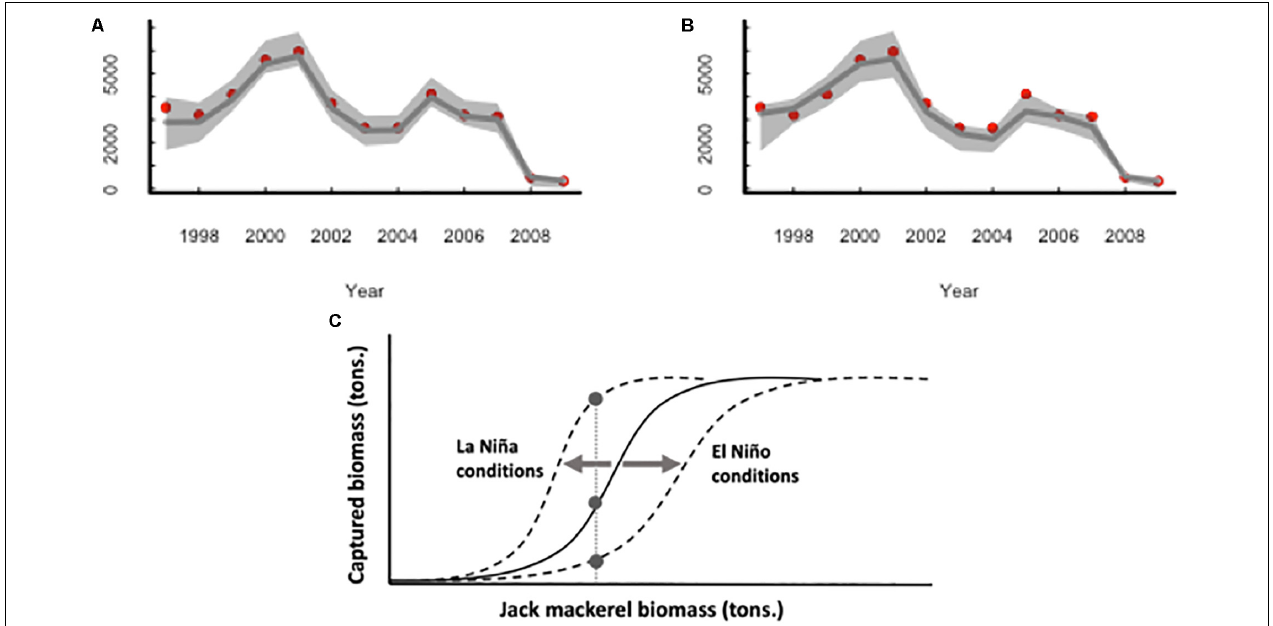
FIGURE 3 | Comparison of the observed jack-mackerel biomass extracted from the acoustic estimates (red dots) for the period 1997–2009 with predictions from models fit to the 1986–2014 estimated biomass from the stock assessment model (gray lines) and the 95% confidence band. (A) predictions from model 1, (B) model 5 from Table 2 , (C) hypothesized ENSO effects on the parameter h (the fish biomass where the fishing rate is half saturated) of the functional response of fishing suggesting that ENSO variability (El Niño/La Niña years) decrease/increase the half-saturated fishing rate. For the same jack-mackerel biomass during the El Niño years the captures biomass is lower than La Niña or normal